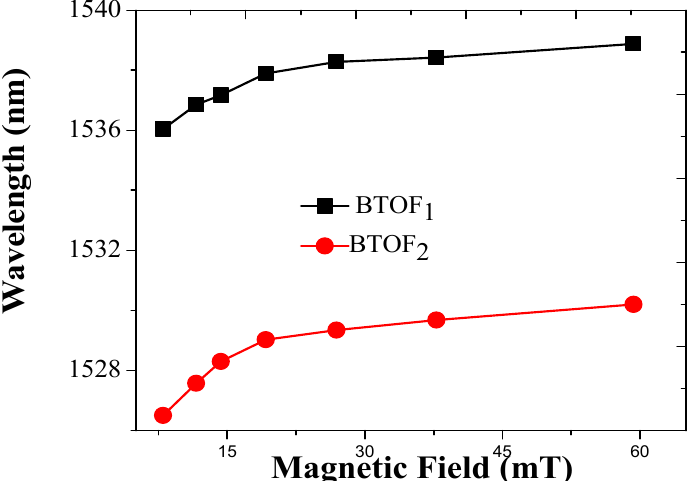
Figure 5. Sensitivities responses for BTOF 1 and BTOF 2 . Using a signal analysis in zone Z 2 .